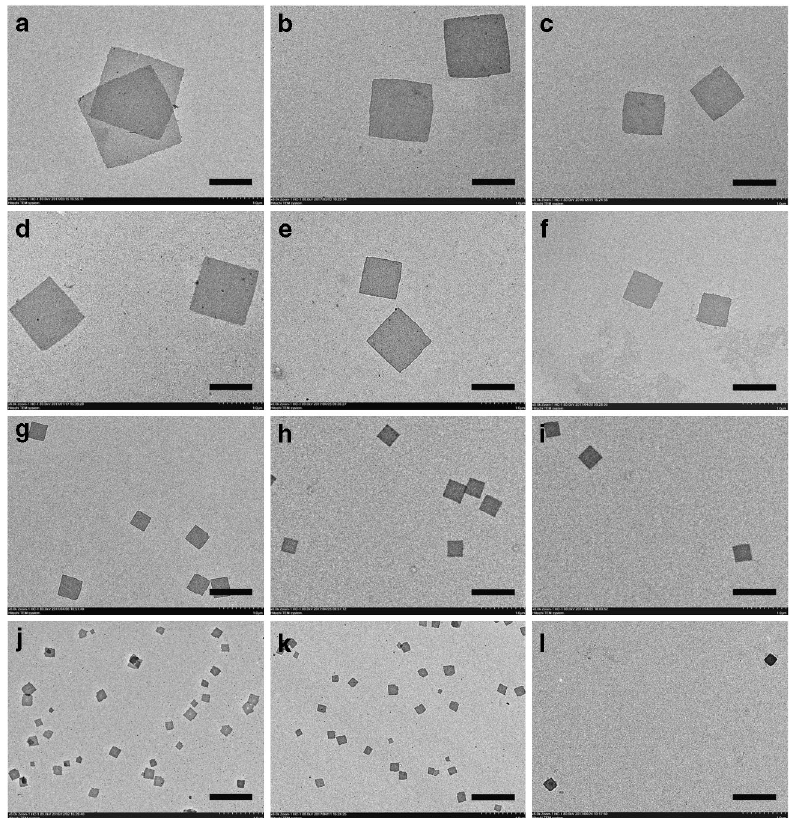
Fig. 3 Concentration dependence of the formation of platelet 2-D square micelles. TEM images of representative samples of 2-D square micelles prepared from PPV 12 - b -P2VP n with different R PPV/P2VP in varying concentrations of solutions. a – c The representative 2-D square micelles of PPV 12 - b -P2VP 12 ( R PPV/ = 1 : 1) grew from the 2-PrOH solution of a 0.01 mg ml − 1 , b 0.005 mg ml − 1 , and c 0.0025 mg ml − 1 . d – f The representative 2-D square micelles of P2VP PPV 12 - b -P2VP 16 ( R PPV/P2VP = 1 : 1.3) grew from the 2-PrOH solution of d 0.01 mg ml − 1 , e 0.005 mg ml − 1 , and f 0.0025 mg ml − 1 . g – i The representative 2-D square micelles of PPV 12 - b -P2VP 22 ( R PPV/P2VP = 1 :2) grew from the 2-PrOH solution of g 0.05 mg ml − 1 , h 0.02 mg ml − 1 , and i 0.01 mg ml − 1 . j – l The representative 2D square micelles of PPV 12 - b -P2VP 36 ( R PPV/P2VP = 1 : 3) grew from the 2-PrOH solution of j 0.05 mg ml − 1 , k 0.02 mg ml − 1 , and l 0.01 mg ml − 1 . Scale bars correspond to 1 μ m in all TEM